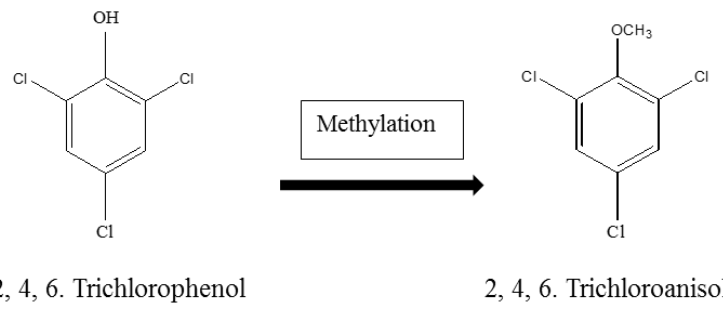
Figure 3. Schematic presentation of the methylation of 2 , 4 , 6 trichlorophenol to 2 , 4 , 6 trichloroanisole.